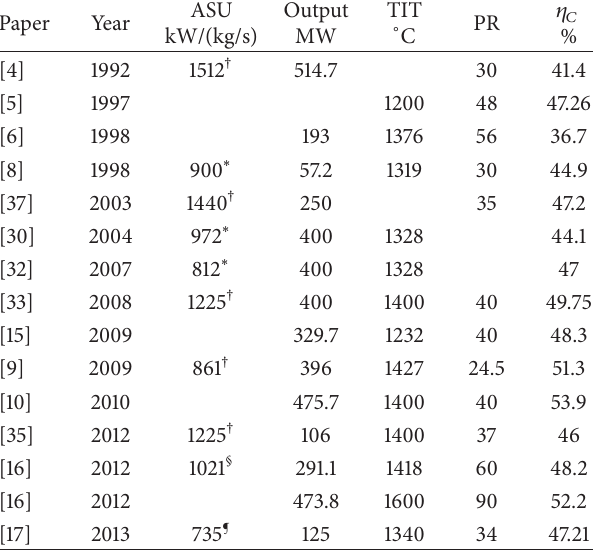
Table 1: Cycle performance for the SCOC-CC from earlier papers.